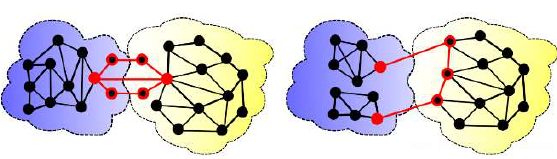
Figure 9 . Examples of bridging graphs